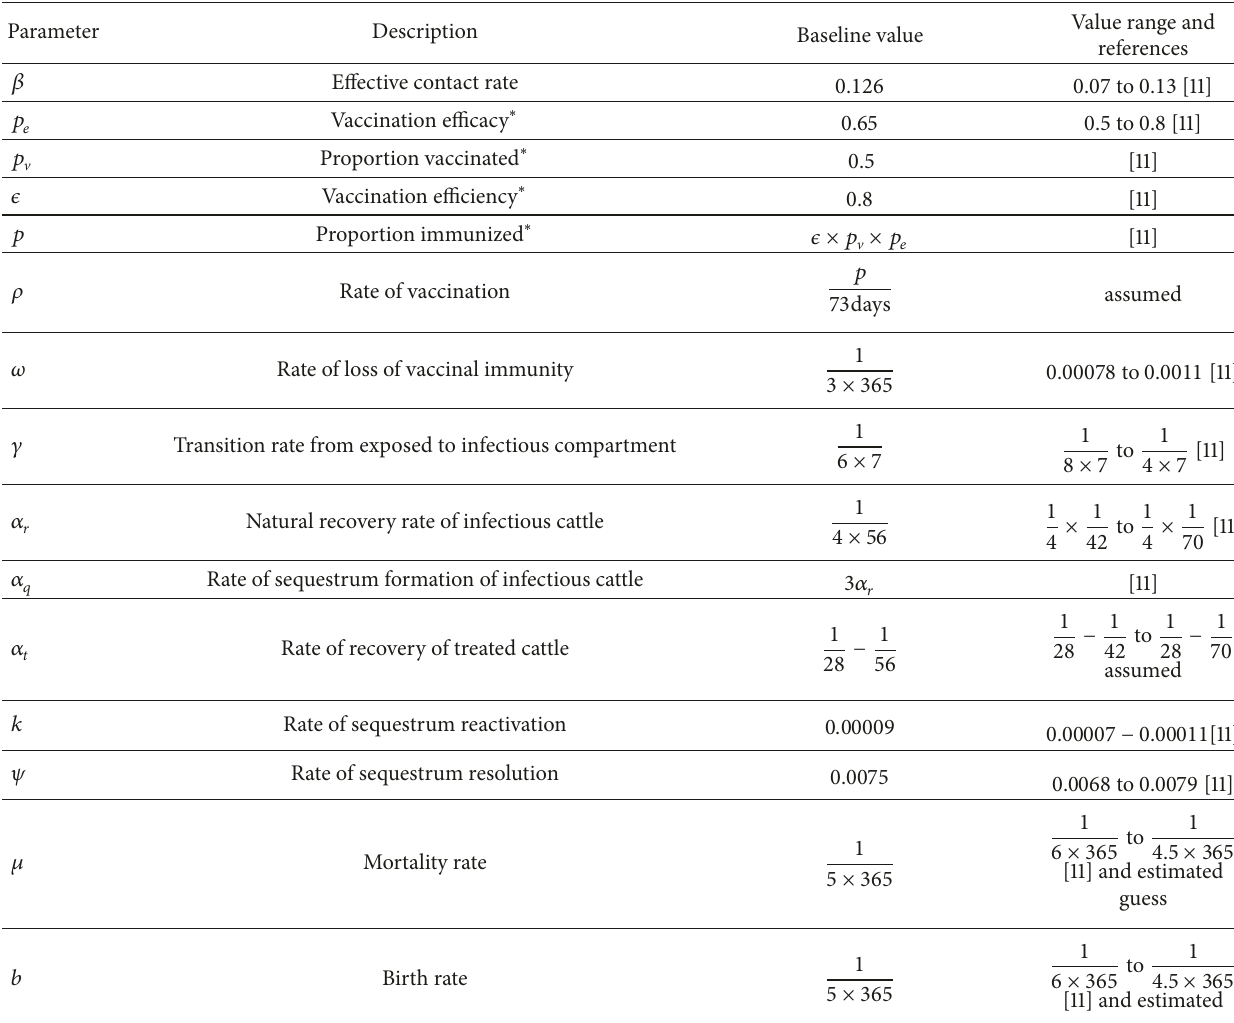
Table 1: Description of model parameters and their values, indicating baselines, ranges, and references. Units are days −1 unless otherwise defined. ∗